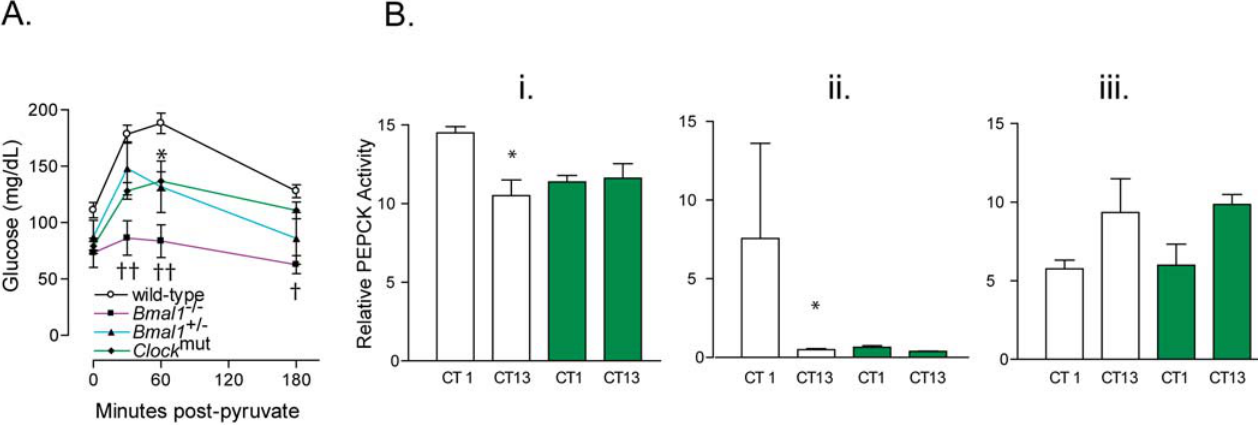
Figure 3. Impaired Gluconeogenesis in Mice with a Disrupted Circadian Clock (A) Pyruvate tolerance was compared among WT (black line), Bmal1 þ / (cid:1) (blue line), and Bmal1 (cid:1) / (cid:1) (purple line), and Clock mut (green line) mice at CT7 ( n ¼ 6–10). (B) Relative PEPCK activity (units are expressed as luciferase activity 3 10 3 ) was measured in liver (i), aorta (ii), and kidney (iii) from WT (white bars) and Clock mut mice (green bars). DOI: 10.1371/journal.pbio.0020377.g003